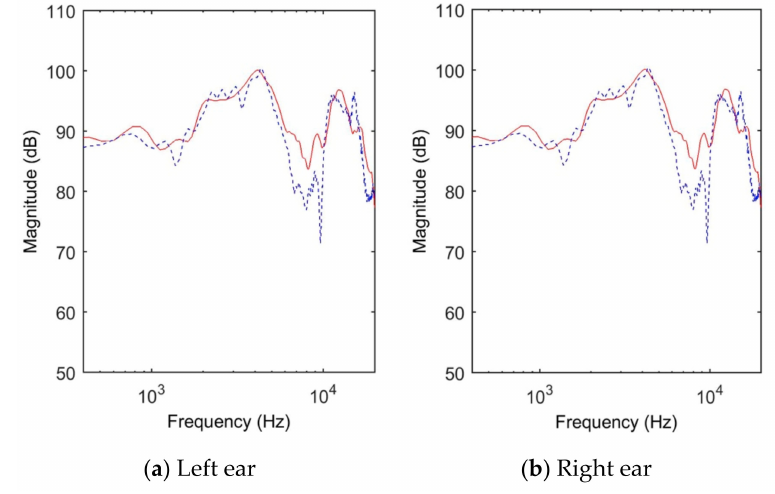
Figure 6. The HRTF magnitude of a typical subject in the validation group at elevation 0 ◦ in the median